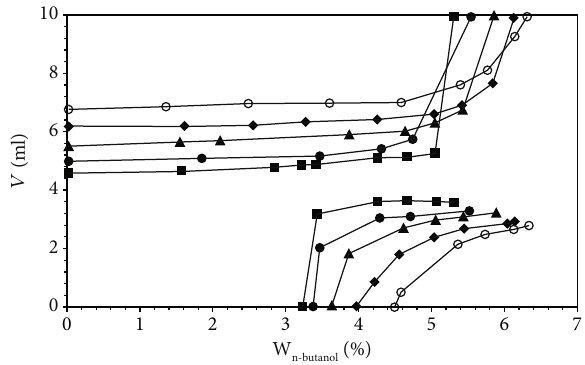
Figure 15: In fl uence of content of surfactant on the Winsor phase